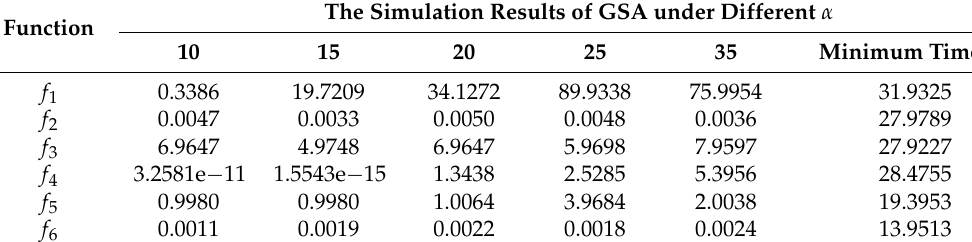
Table 3. The simulation result of different